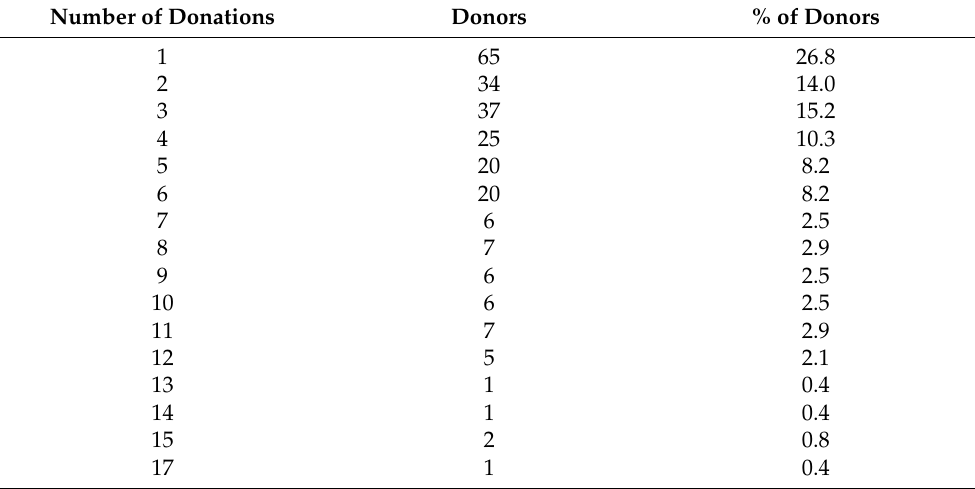
Table 4. Number of donations per